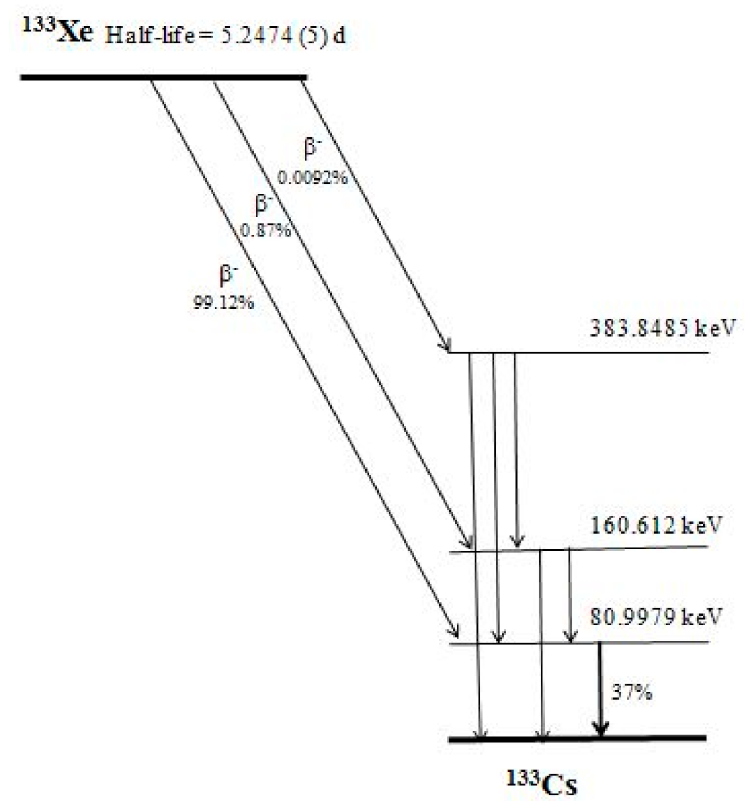
Figure 1. Decay scheme of 133 Xe. The half-life, probability of the decay modes and energy of the excited states are shown, using the data of Ref. [25]. The present method uses the gamma-line of energy 80.9972 ( ≈ 81 kev) that is of emission probability of